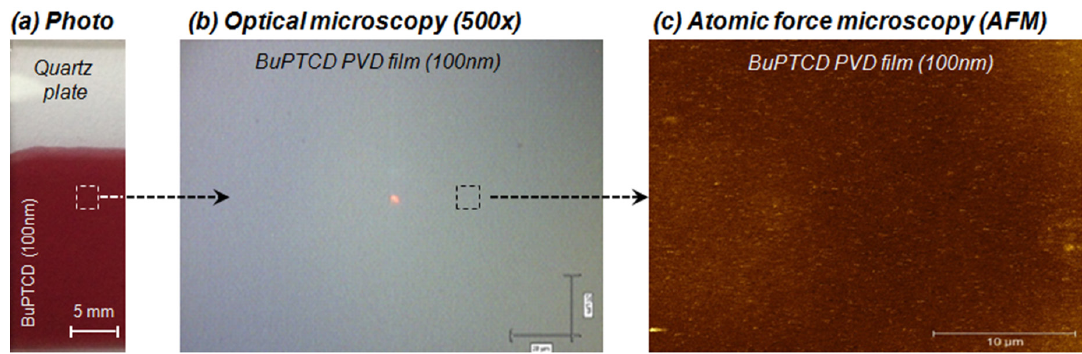
Figure 3. (a) Photograph obtained with a digital camera, (b) optical microscopy with 500× magnification, and (c) atomic force microscopy (AFM, topography) for the 100 nm PVD film deposited onto quartz plate.